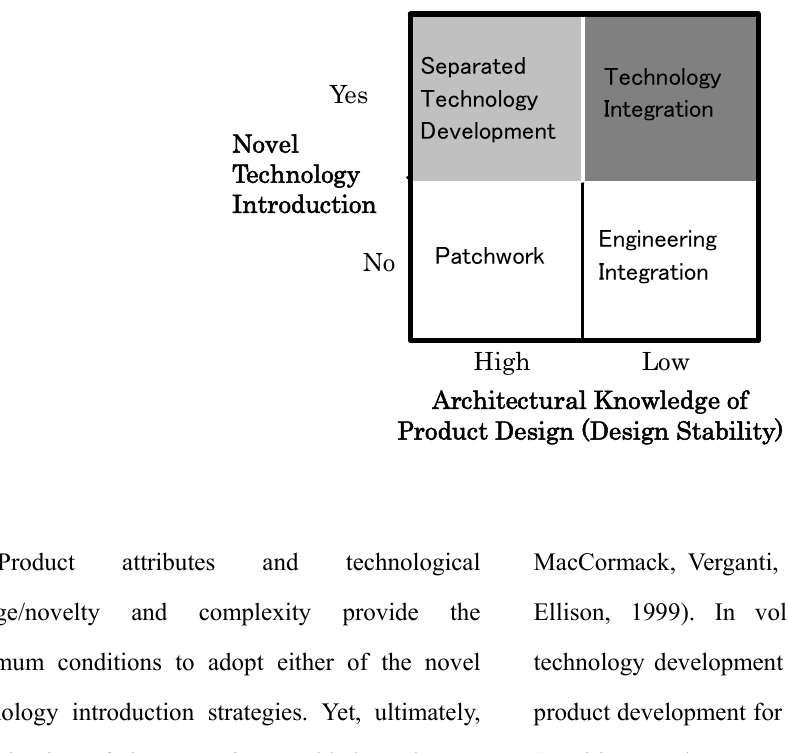
Figure 1. Novel technology introduction and product development